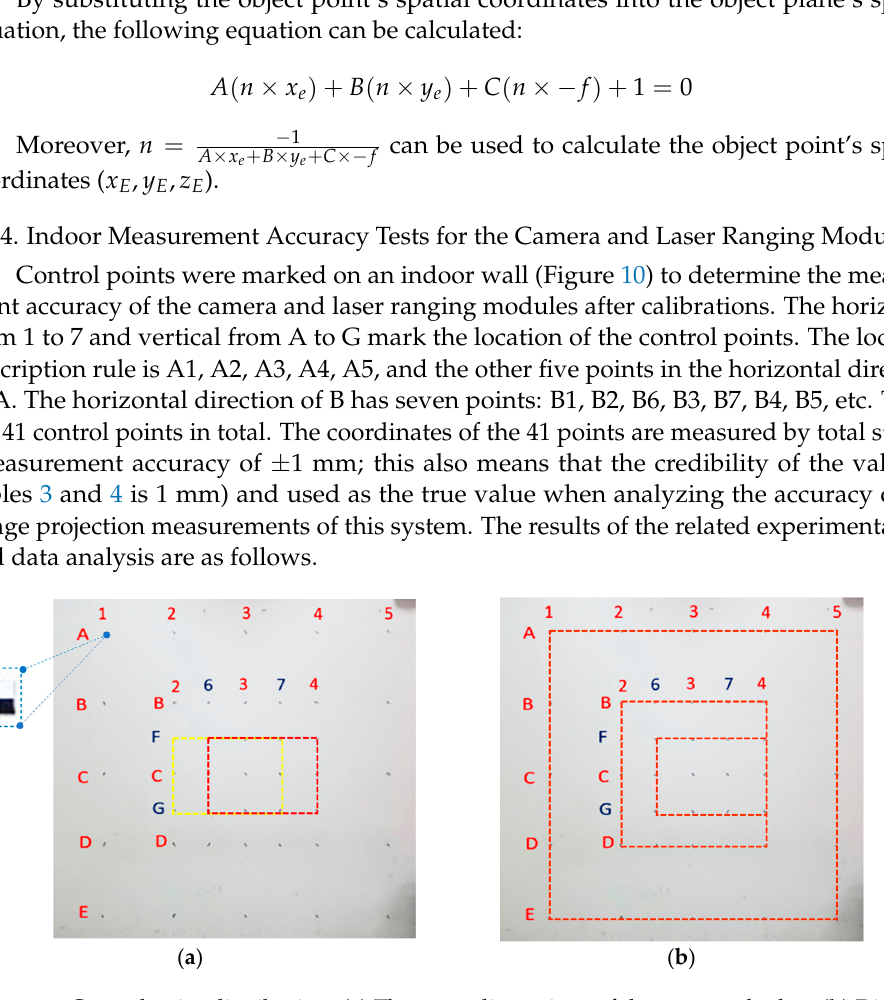
Figure 10. Control point distribution. ( a ) The same dimensions of the rectangular box ( b ) Different dimensions of the rectangular box. Table 3. Range size and error analyses at measurement distances of 1, 2, and 3